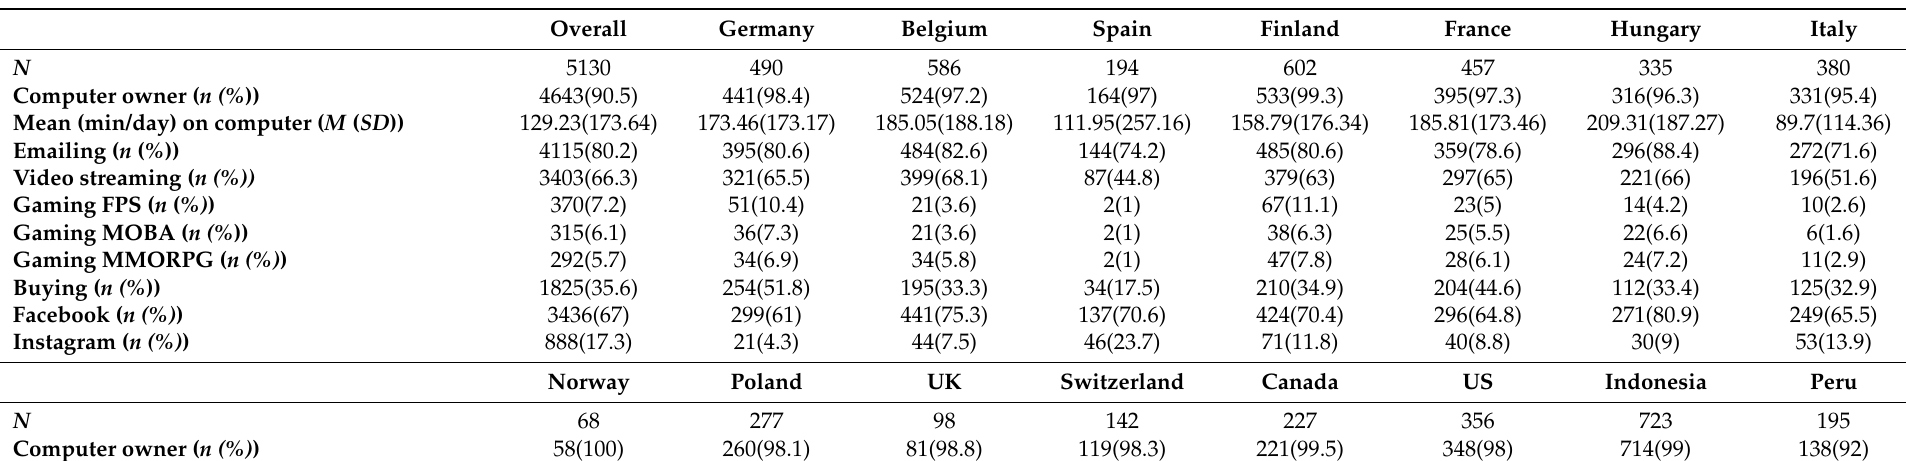
Table 2. Online usage patterns per